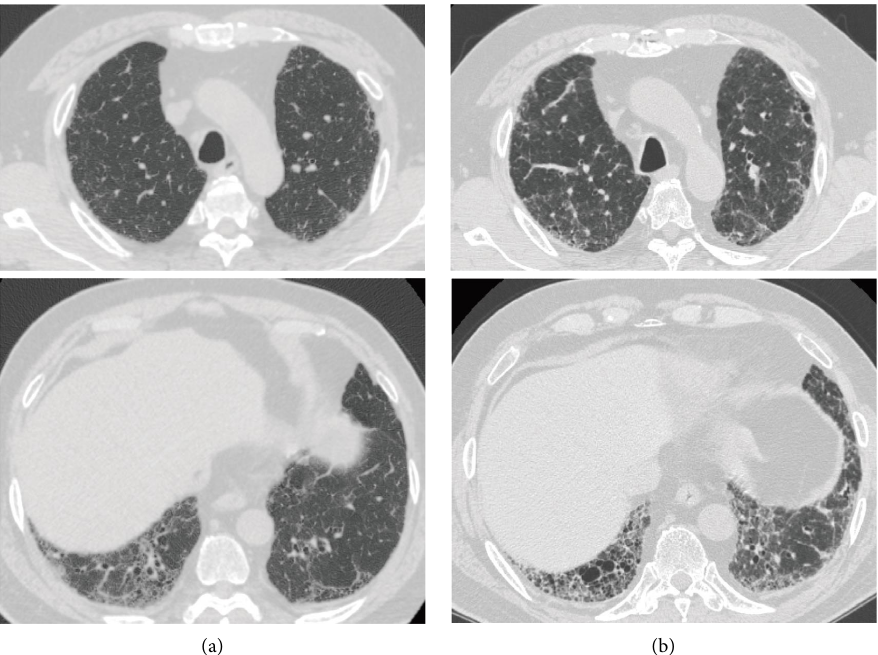
Figure 1: High-resolution CT scans of a representative 62-year-old man sarcoid patient at the time of diagnosis (a) and 3years after diagnosis Table 3: Radiographic (high-resolution computed tomography) presentations in patients with pulmonary sarcoidosis. Lower dominance